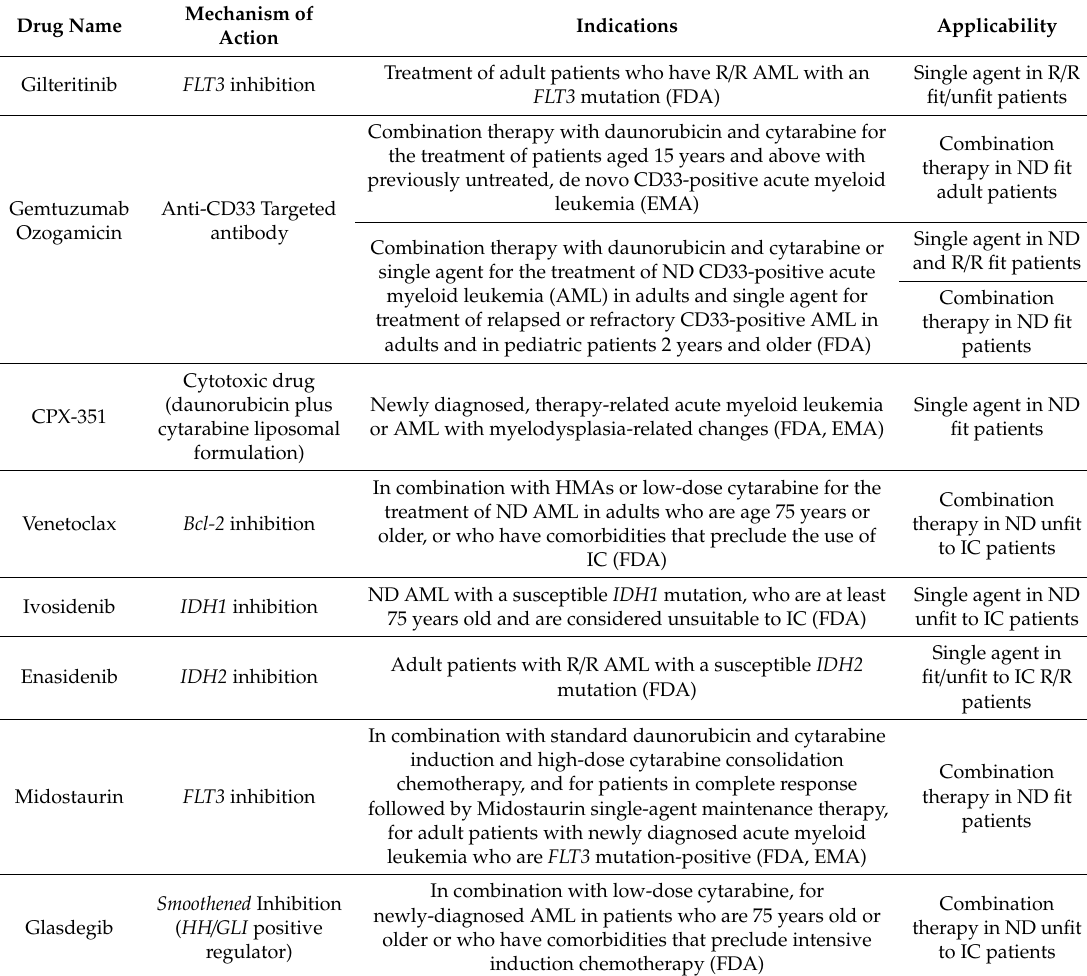
Table 2. Newly approved drugs for the treatment of AML and their possible fields of application according to the SIE, SIES, GITMO